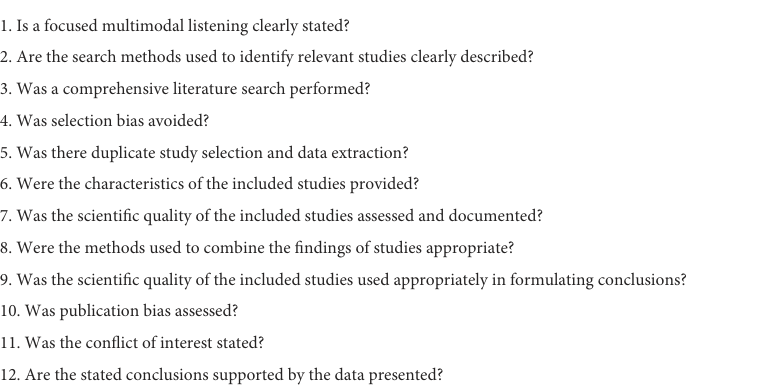
TABLE 1 Criteria used in quality assessment of systematic reviews.